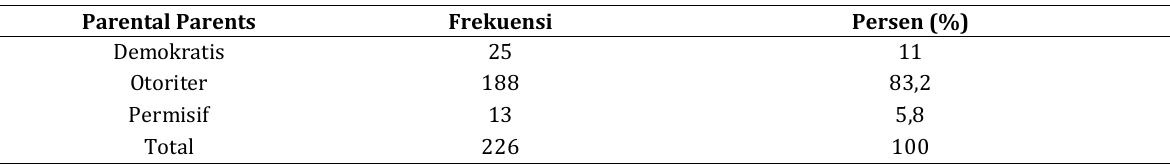
Table 3. Frequency Distribution of the Respondents Based on the Parenting Style of the Adolescents at SMKN 3 Banjarbaru